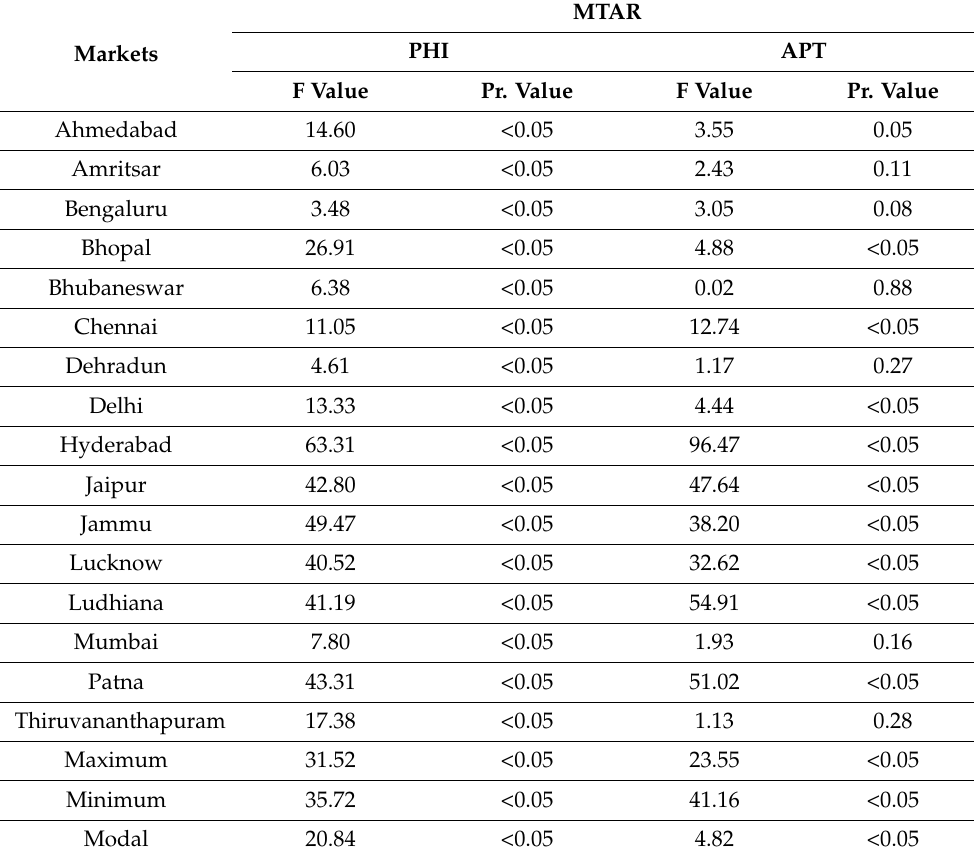
Table 6. Asymmetric